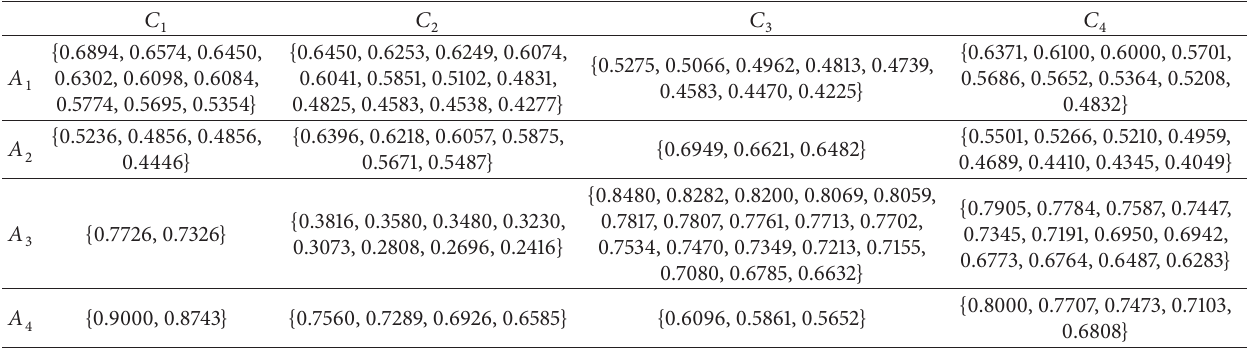
Table 5: The collective hesitant fuzzy decision matrix R .